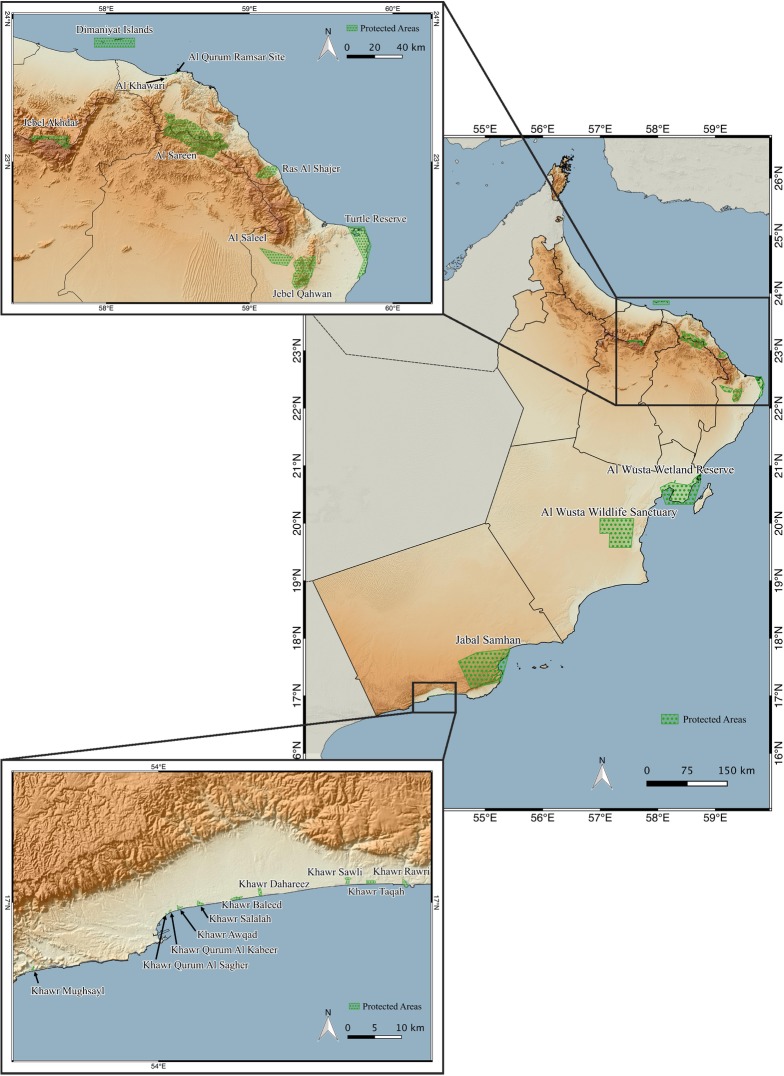
Map of protected areas of Oman.Topographical map of Oman showing the distribution, limits and names of the 22 protected areas. Information provided by the Ministry of Environment and Climate Affairs of Oman.